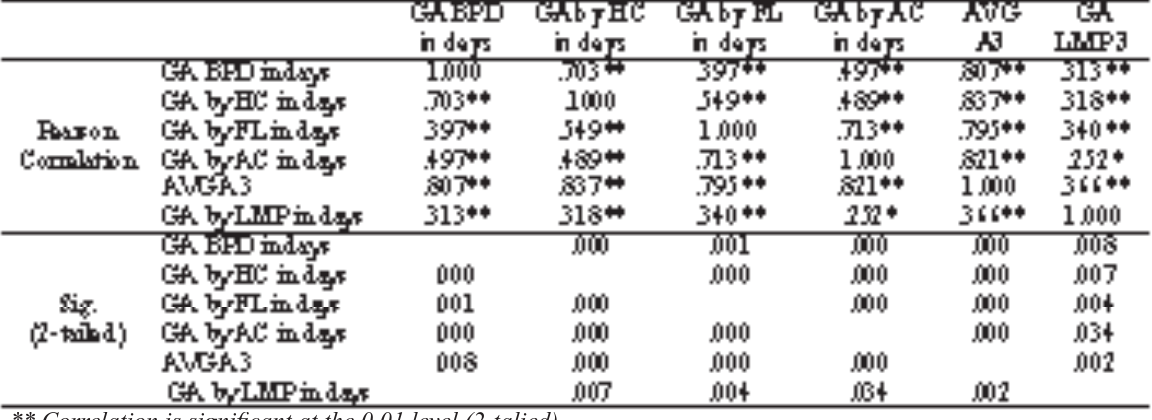
** Correlation is significant at the 0.01 level (2-talied). * Correlation is significant at the 0.05 level (2-tailed). AVGA 3 = Average gestational age in 3 rd